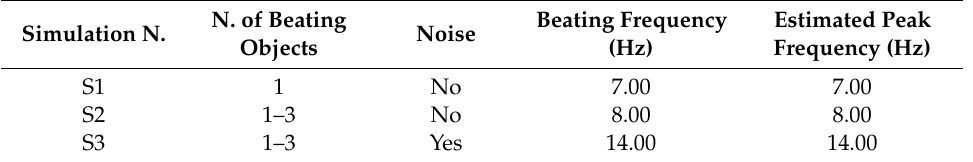
Table 2. Recap of simulated beating patterns for experiment number 1. The simulated beating frequency and the estimated one are identical. N. of Beating Beating Frequency Estimated Simulation N. Noise Objects (Hz)